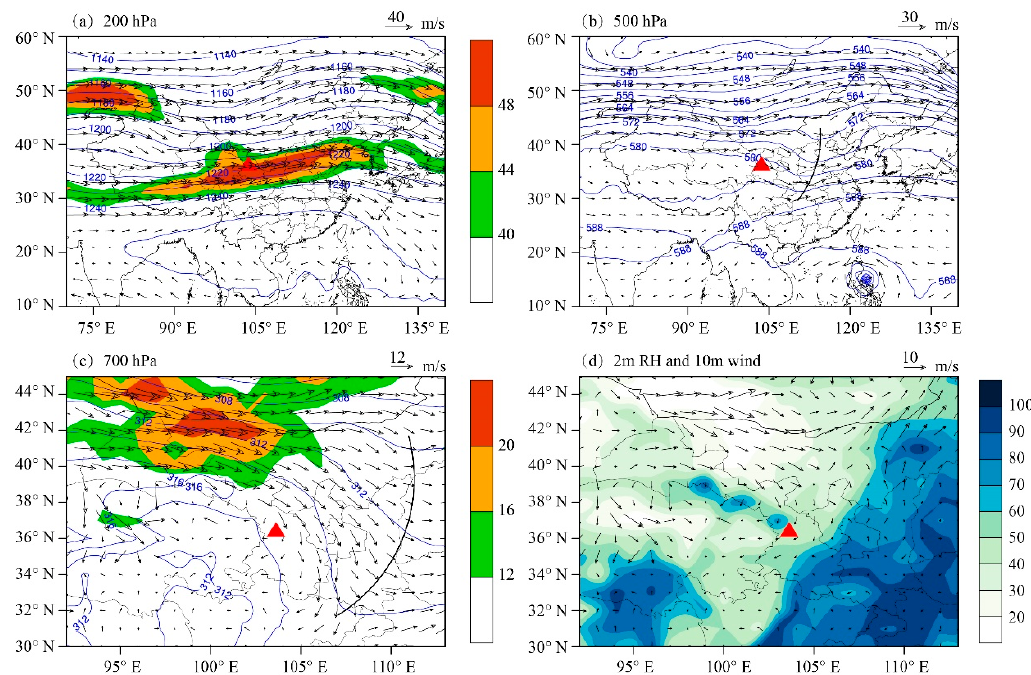
Figure 1. Horizontal distributions of the geopotential height (contour; dagpm) and wind vectors (m s –1 ) at ( a ) 200, ( b ) 500, and ( c ) 700 hPa, and ( d ) 2 m relative humidity (RH) (filled; %) and 10 m wind vectors from the NCEP final (FNL) data at 12:00 UTC on 15 October 2016. The filled areas in ( a , c ) indicate the upper-level jet and low-level jet with a wind speed > 40 and > 12 m / s, respectively. The thick black lines represent troughs, and the red triangle indicates the site of Lanzhou Zhongchuan International Airport (ZLLL).